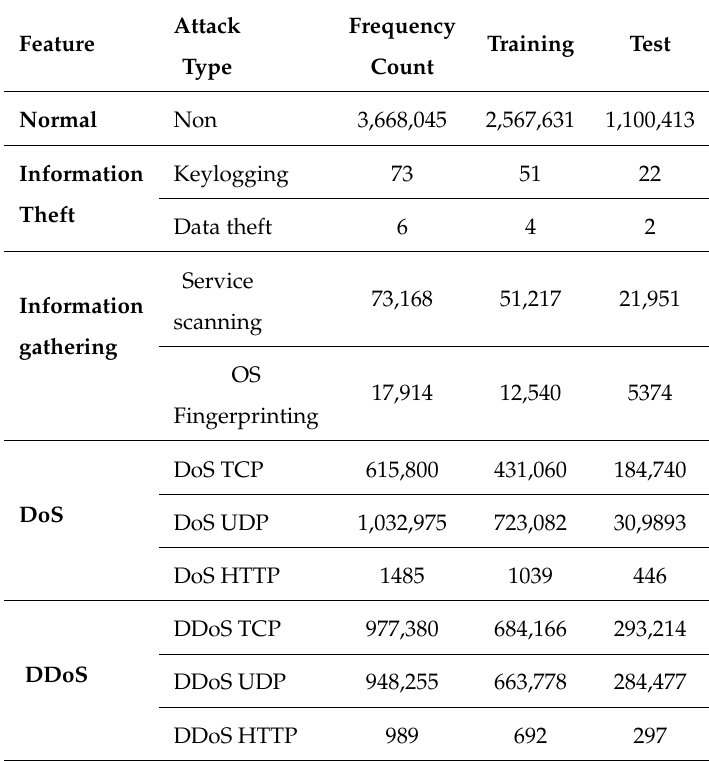
Table 4. Frequency distribution of considered